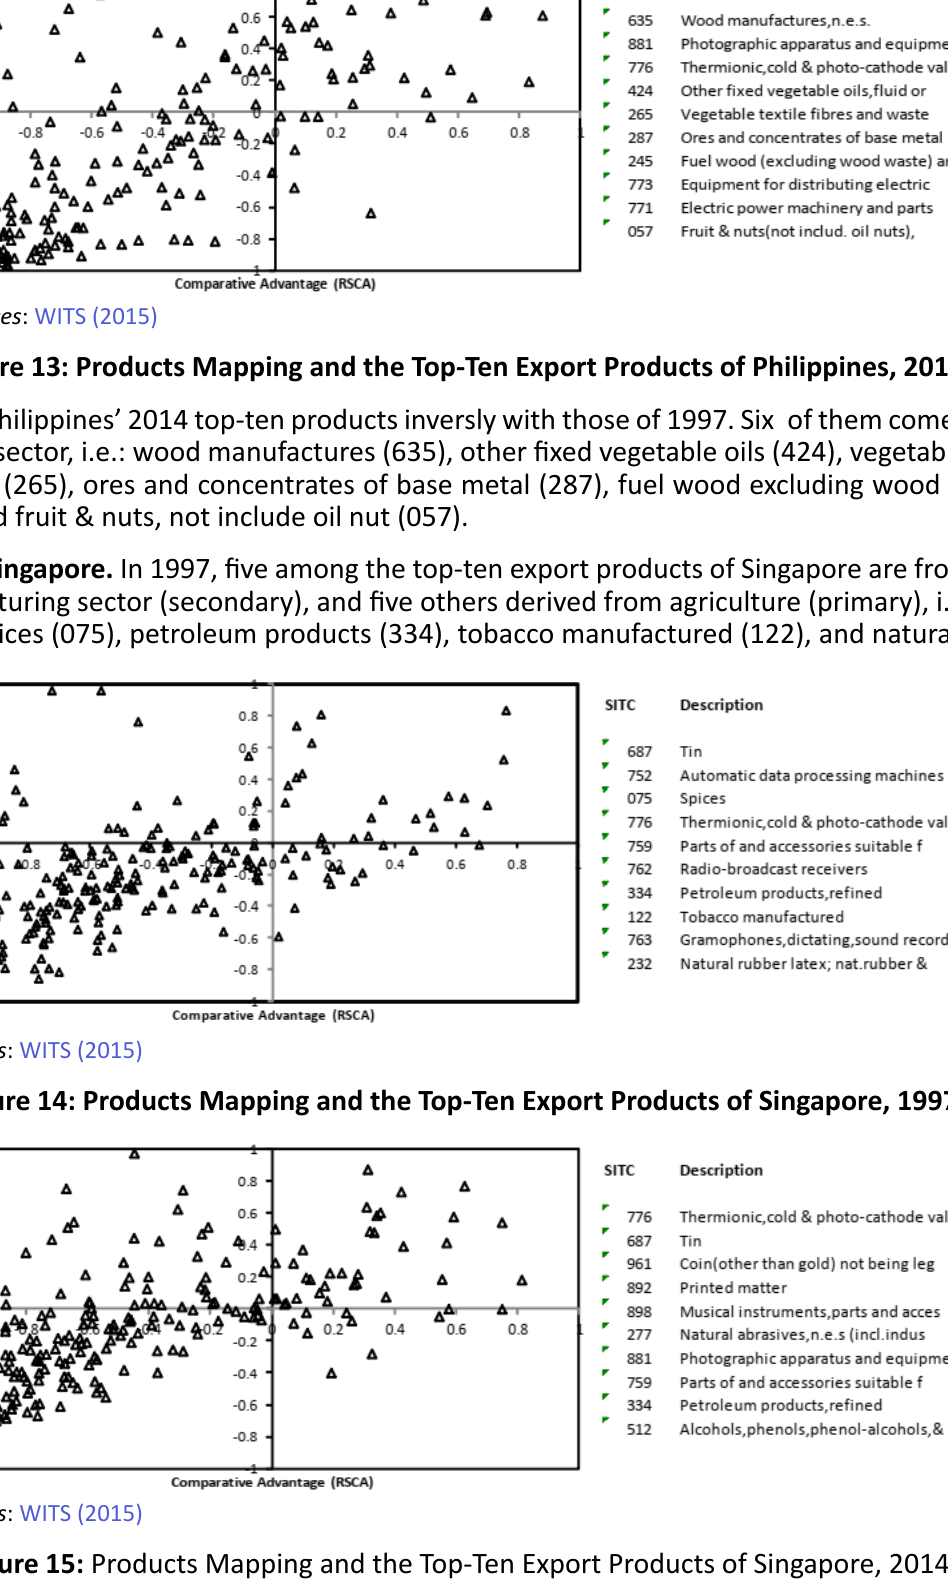
Figure 15: Products Mapping and the Top-Ten Export Products of Singapore,